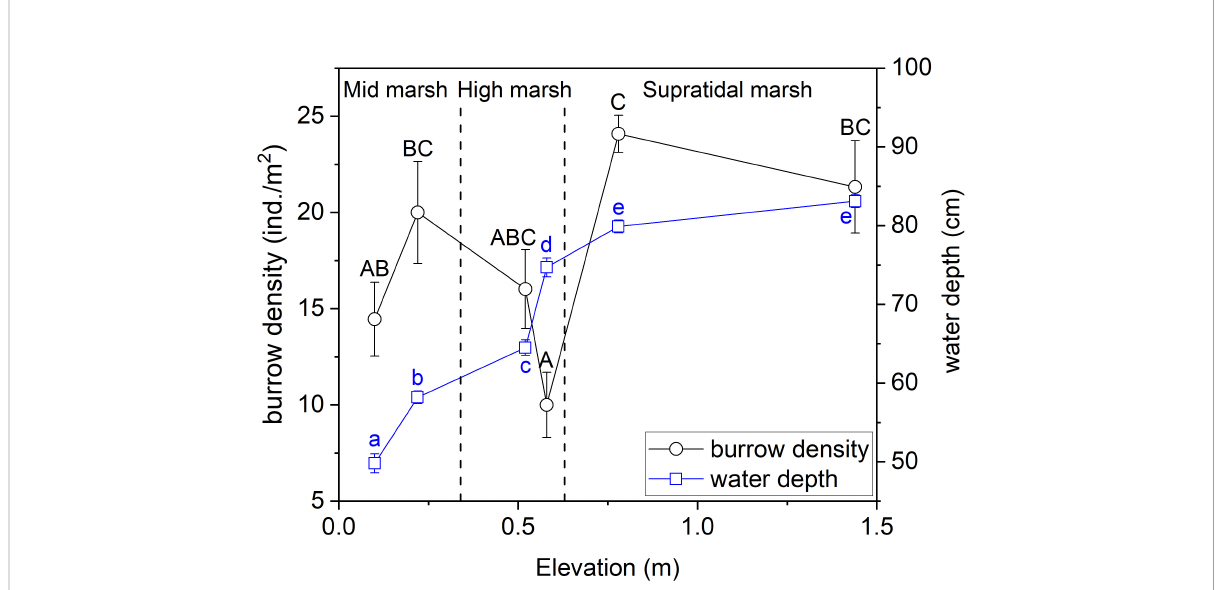
FIGURE 4 Crab burrow density and water depth across the three tidal salt marshes. Data are shown as means ± SE. Lowercase letters indicate signi fi cant differences among different water depth datasets and capital letters indicate signi fi cant differences among burrow density datasets, with a Tukey test.